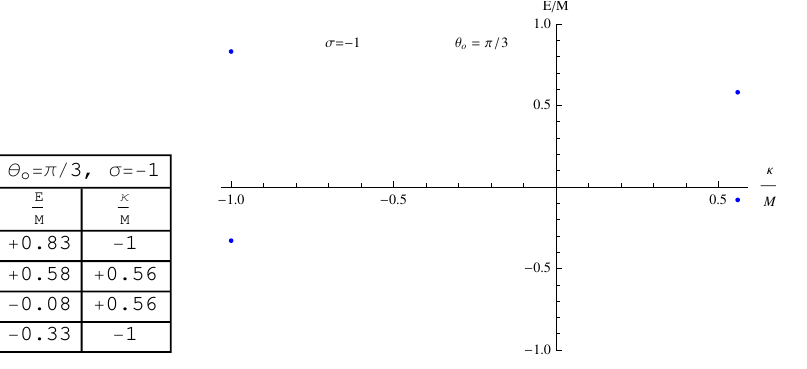
Figure 5 . The left table shows the E/M and κ/M values for θ 0 = π/ 3 , σ = − 1 .The right figure shows the points with coordinates ( κ/M , E/M )